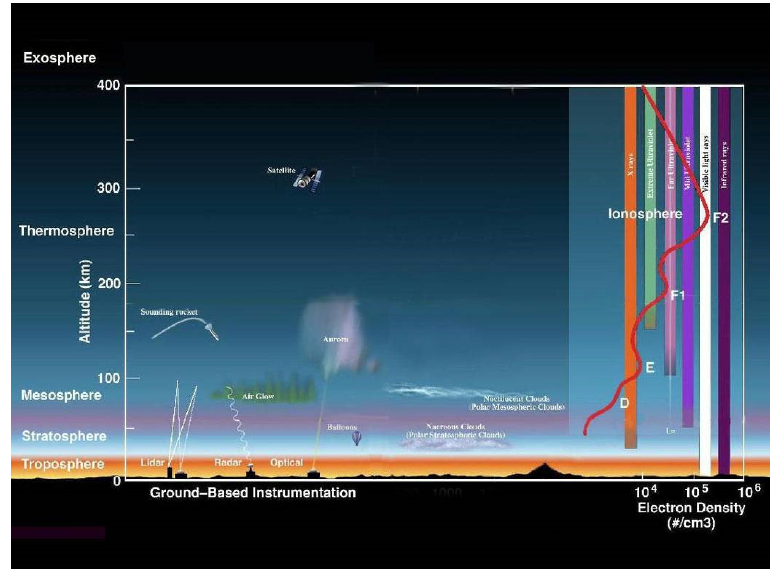
Figure 19. Earth’s atmospheric